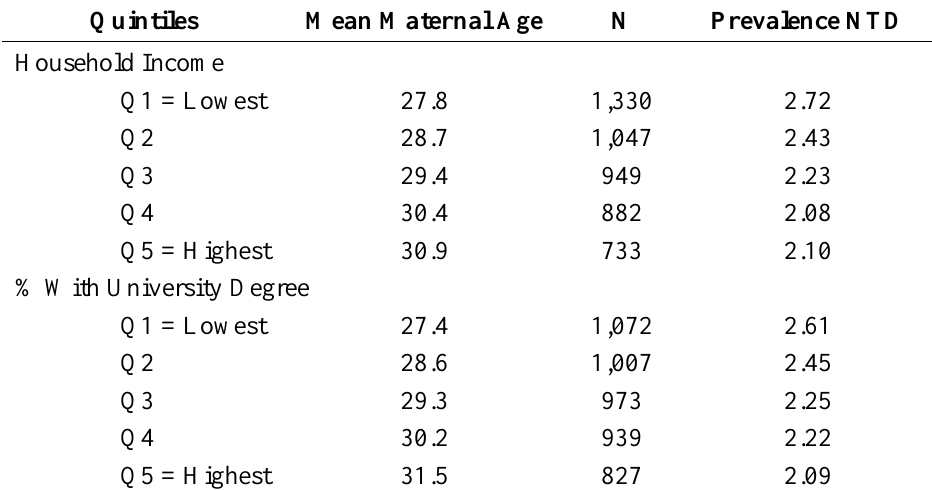
Table 2. Birth prevalence (/1,000) of Neural Tube Defects (NTD) by socioeconomic indicators, Ontario 1994  2009. Quintiles Mean Maternal Age N Prevalence NTD Household Income Q1 = Lowest 27.8